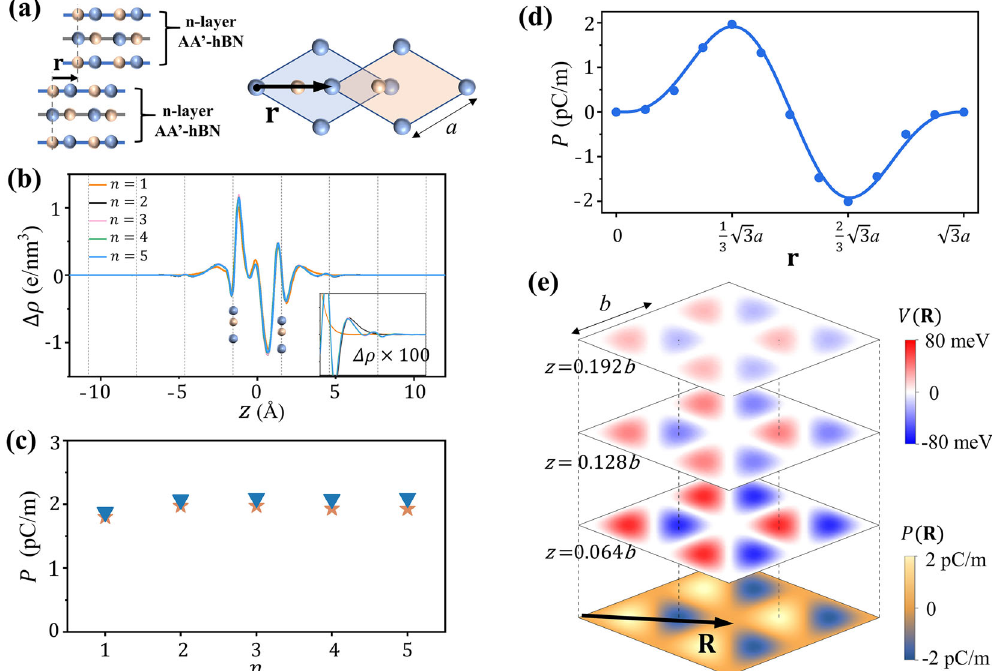
ffiffiffi p 3 . Δ ρ (cid:3) ρ n þ n (cid:1) ρ n ; t (cid:1) ρ n ; b , where ρ n + n is the plane- R z Δ ρ ð z Þ dz (stars), and using ε Δ φ (triangles), Δ φ being 0